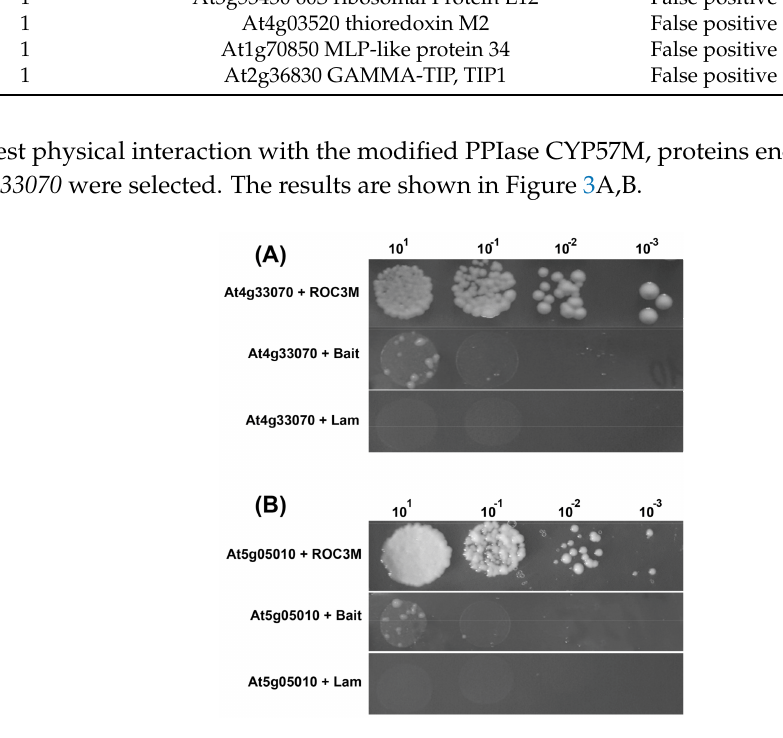
Figure 3. Cotransformation of CYP57M with At4g33070 ( A ) and At5g05010 ( B ) by the yeast two-hybrid system, and two negative controls: an empty bait vector pGBKT7 and pGBKT7 carrying the noninteracting human protein gene lamin C with CYP57M. The initial culture of OD600 = 0.2 was used, sequentially diluted to 10 − 3